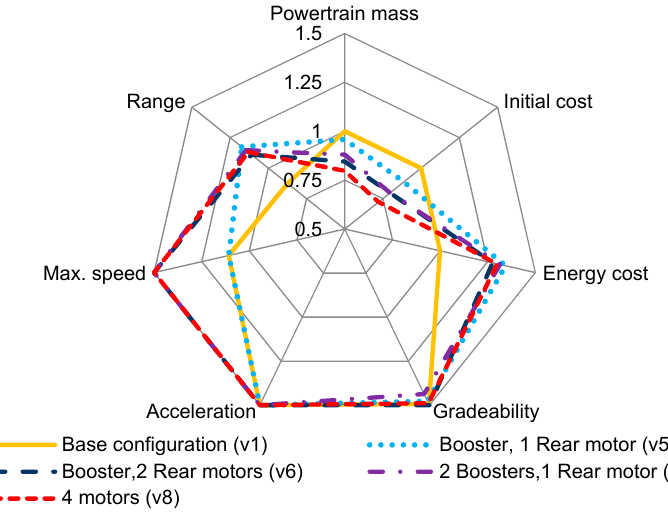
Figure 11. Vehicle characteristics of versions 1 and 5–8.